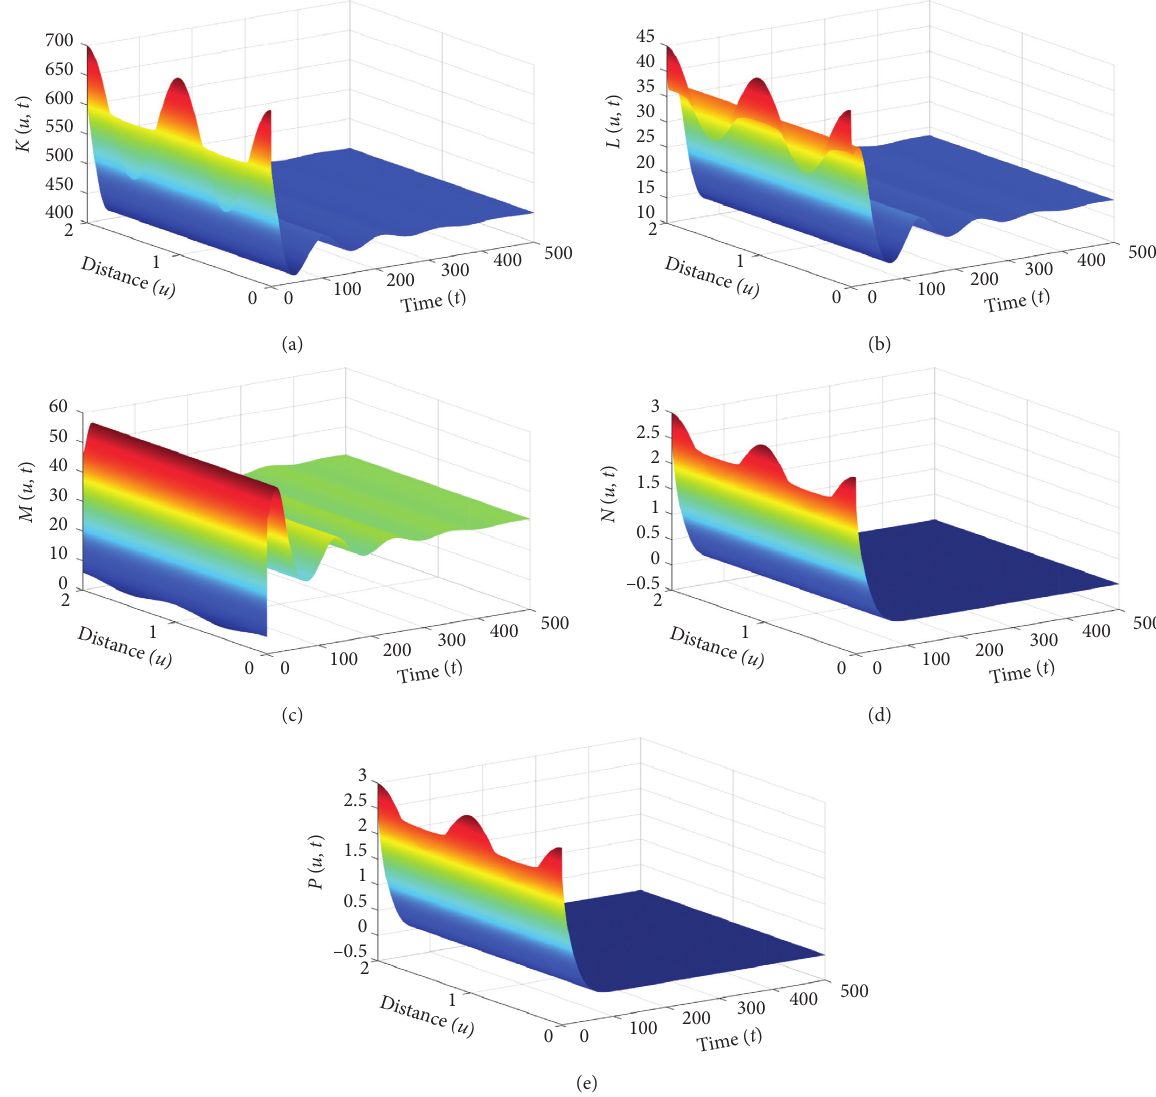
� ( 450 , 18 . 333 , 30 . 556 , 0 , 0 ) is asymptotically stable. (a) Target ≤ 1 < R and R ≤ 1), the equilibrium Ω 1 0 2 1